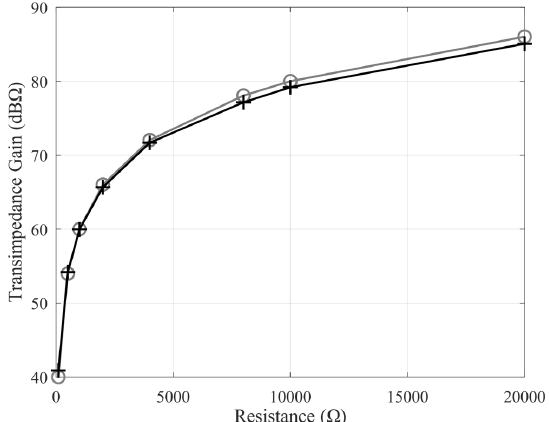
Figure 13. Ideal (grey trace) and measured (black trace) transimpedance gain at different values of the external X terminal gain resistor.